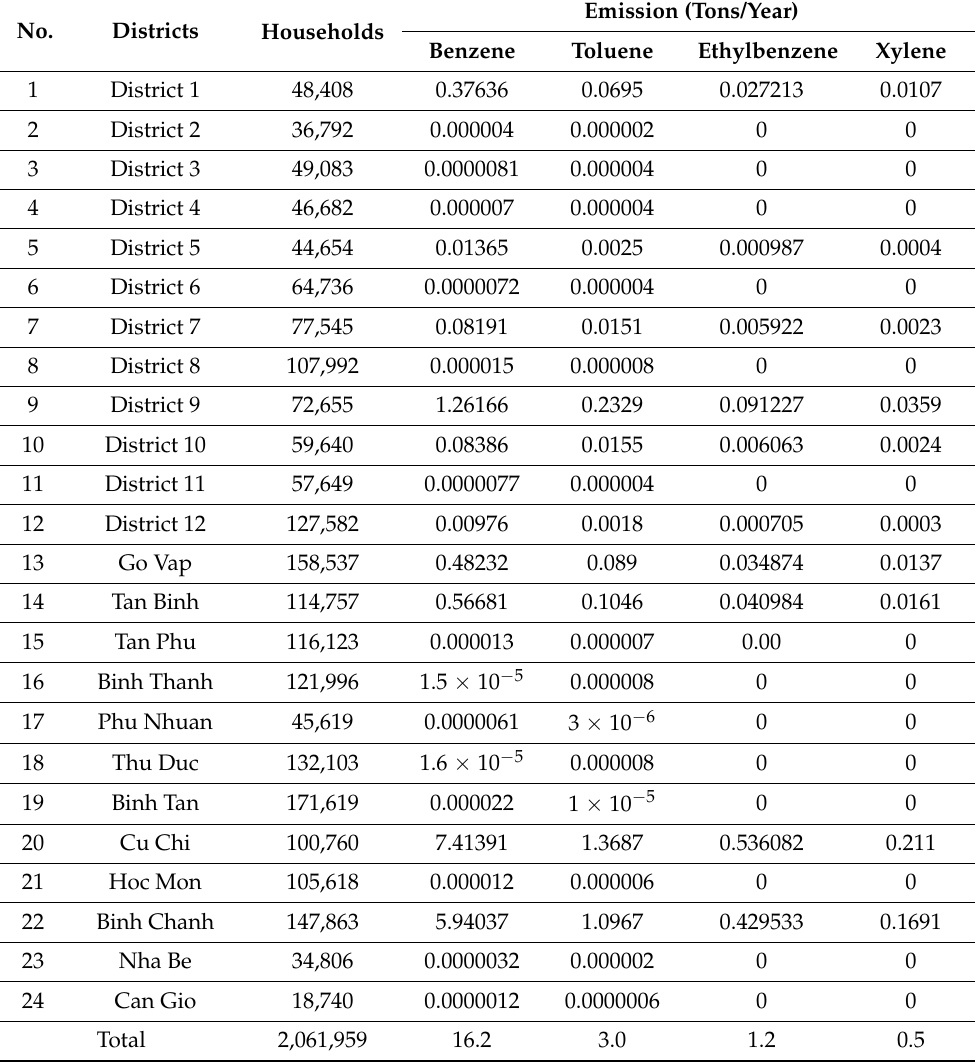
Table 5. Emission from households at different districts due to LPG and coal